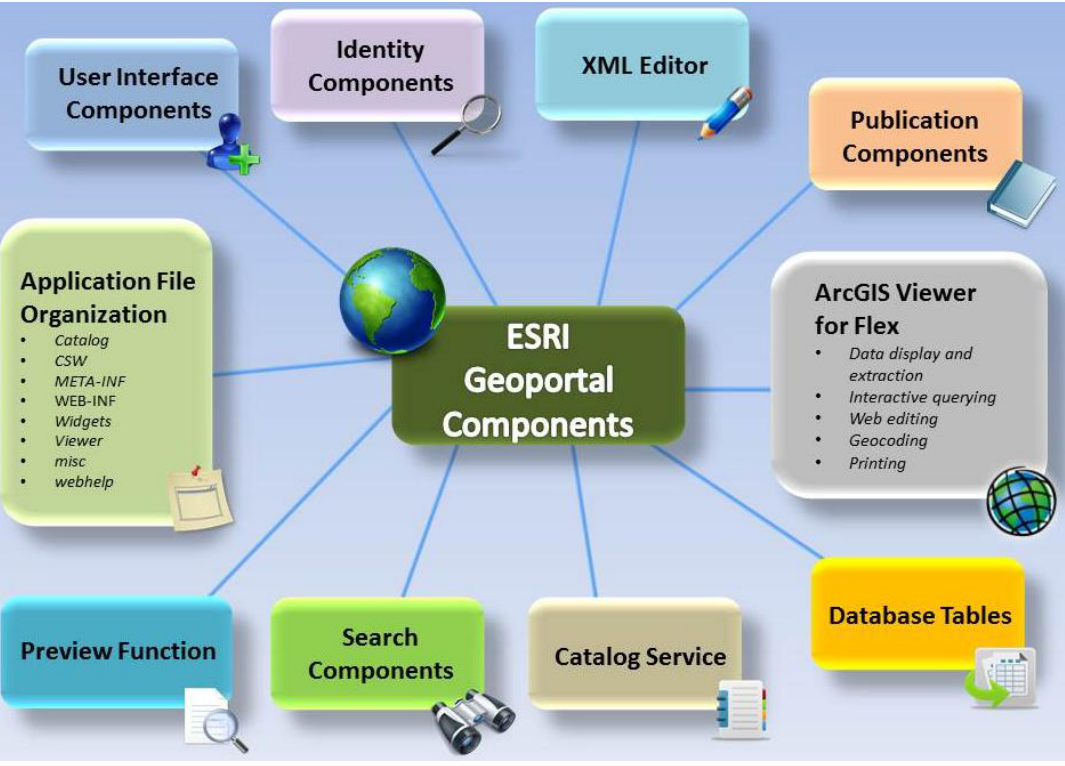
Figure 3. Components of the ESRI Geoportal